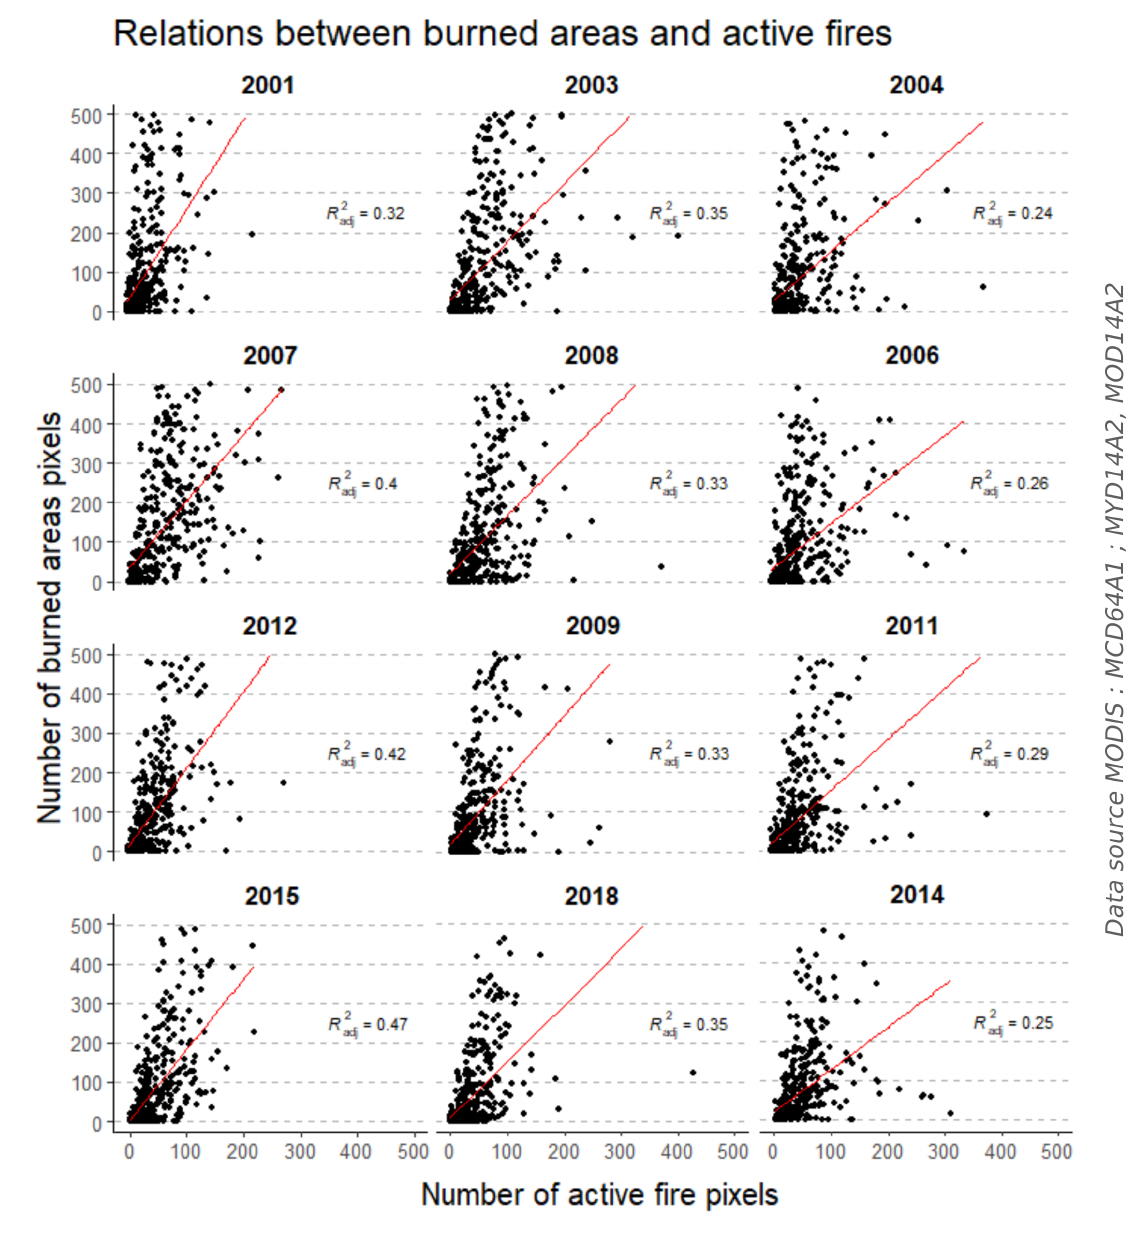
Figure 4. Correlation between burned areas and active fires. Example of some years, classified by